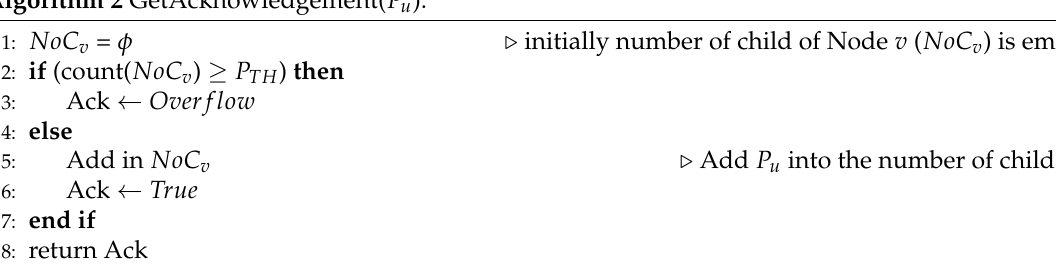
Algorithm 2 GetAcknowledgement( P u